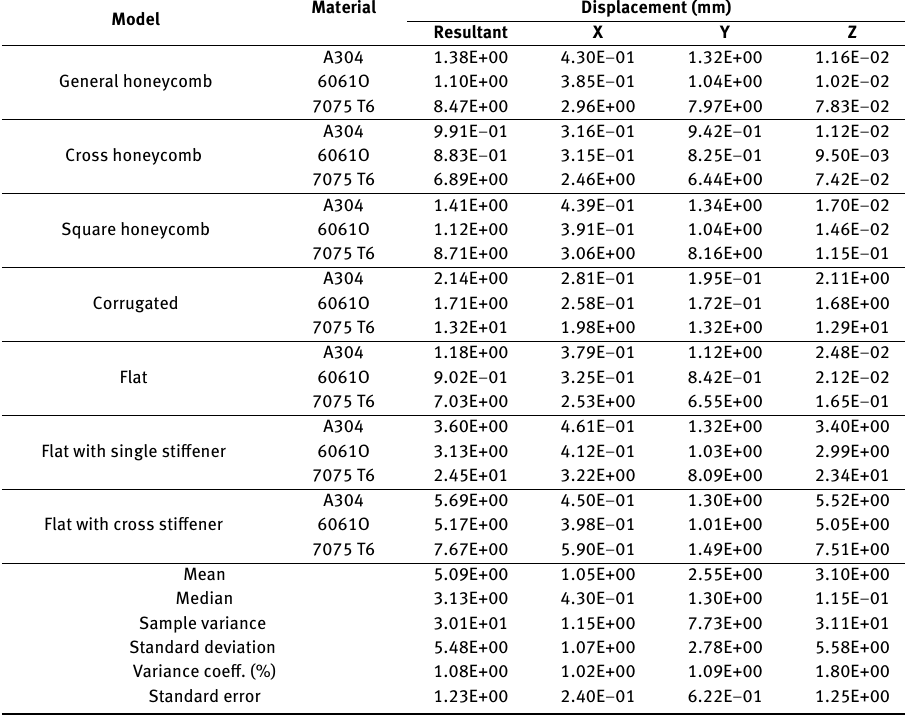
Table 8: Summary of the displacement